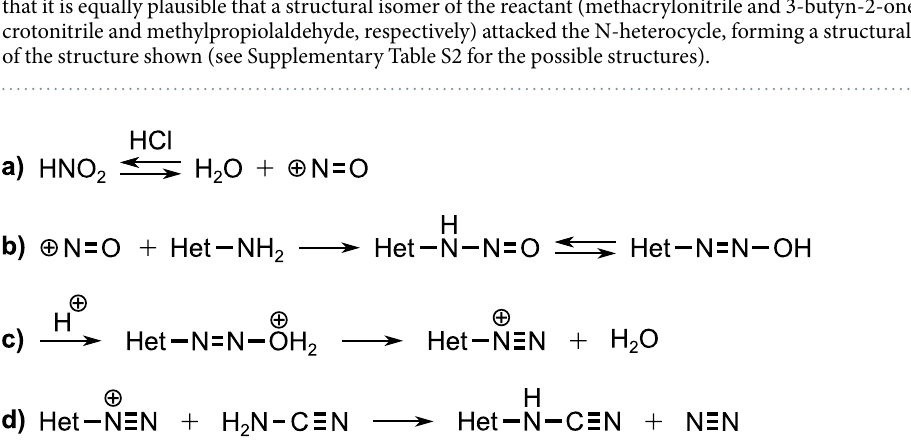
Figure 4. Proposed formation mechanism of cyanamide adducts from N-heterocycles with exocyclic amine groups that were incubated with a neutral spark reaction mixture. ( a ) Nitrous acid forms nitrosonium ions. ( b ) The amine groups of N-heterocycles undergo nitrosation and eventually form ( c ) diazonium cations that undergo ( d ) nucleophilic substitution with cyanamide (H 2 N-CN) or the cyanamide derivative, urea (H 2 N- CONH 2